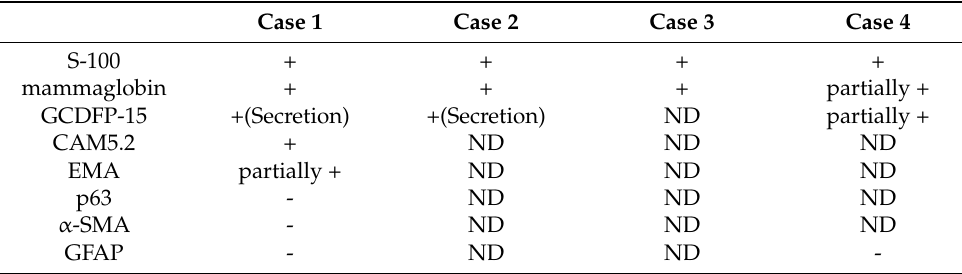
Figure 5. Immunohistochemical findings. Immunohistochemically, neoplastic cells are positive for S-100 ( A ) and mammaglobin ( B ). The secretions are positive for mammaglobin ( B ) and GCDFP-15 ( C ). In addition, d-PAS staining reveals intracytoplasmic and intraluminal secretions and intracytoplasmic granules (( A – C ): case 1, immunohistochemical staining. ( A ): × 400, ( B , C ) × 200, ( D ): case 1, d-PAS staining, × 400). Table 3. Summary of immunohistochemical features.